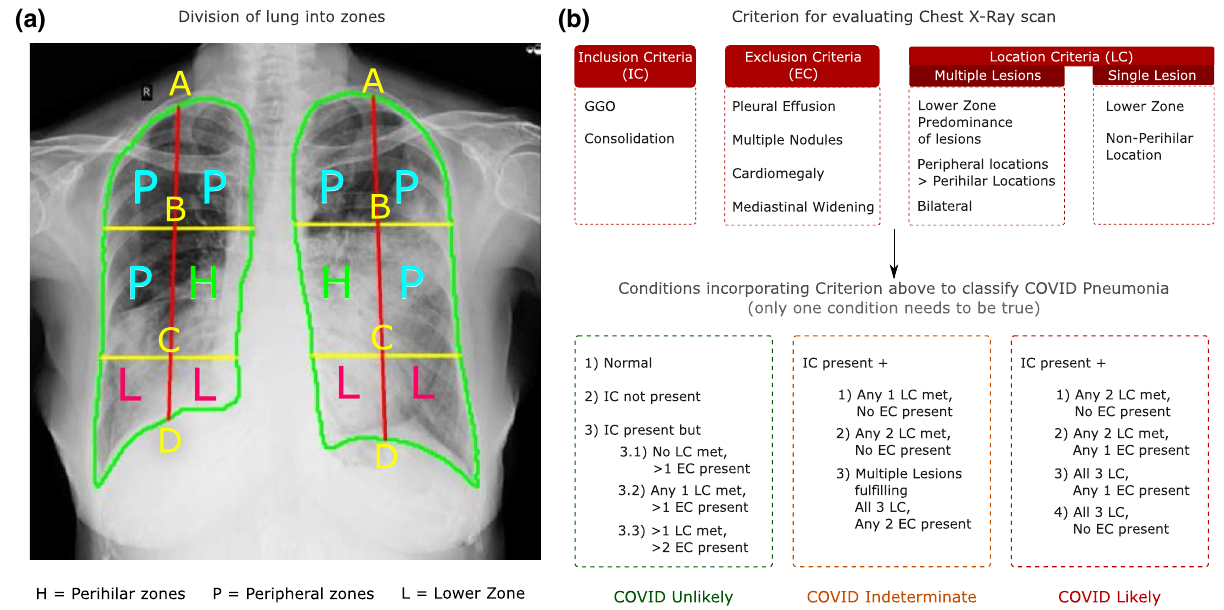
Figure 2. ( a ) Lung partitioning framework. ( b ) Rule-based expert decision system devised by